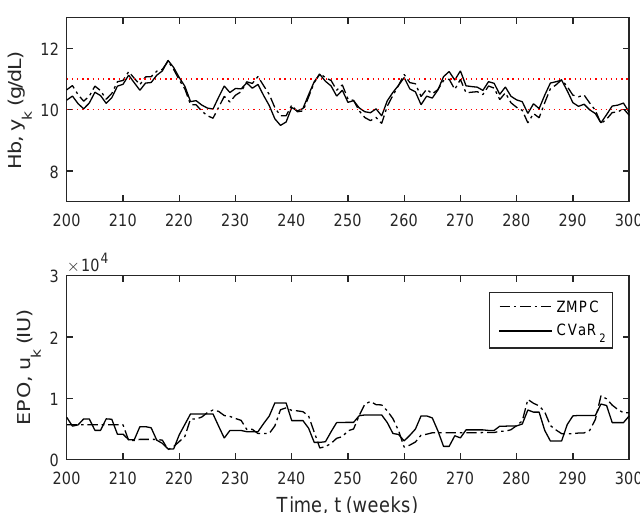
Figure 7. Comparisons to CVaR 2 for the uniform